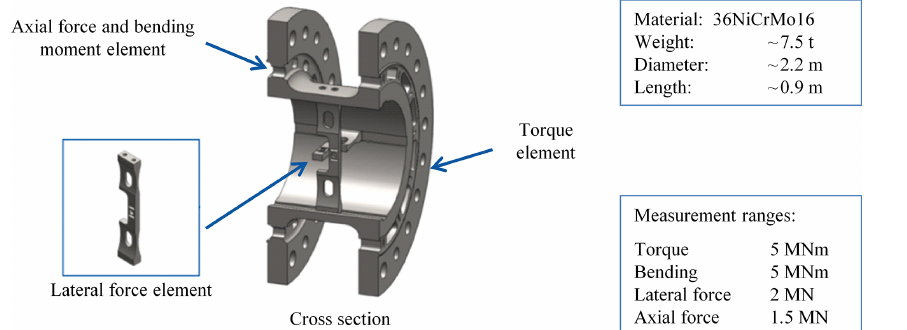
Figure 8. Developed design of a MCT for TB.